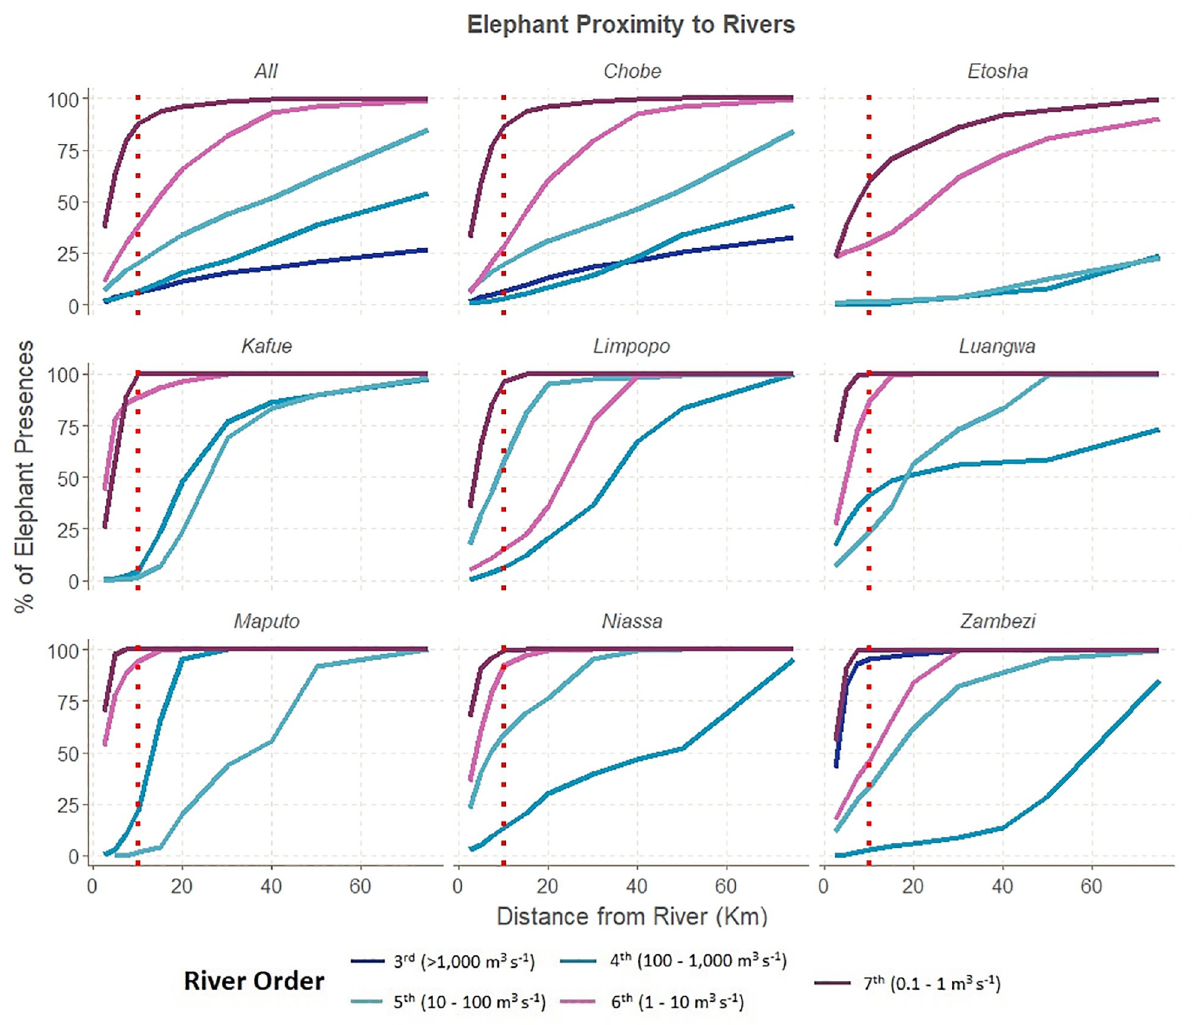
Fig 2. Amount of land and elephant presences within distances of varying river sizes. Accumulation curve of elephant telemetry points as the distance increases away from rivers of varying flow orders. The red dashed line indicates the 10 km preference